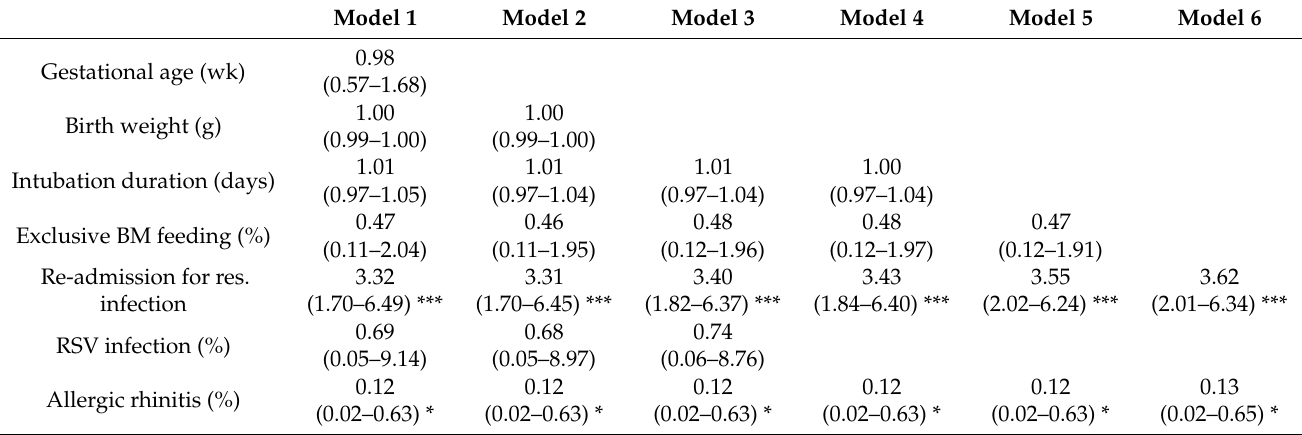
Table 2. Multivariable logistic analysis of early life factors between wheezing and non-wheezing groups. Model 1 Model